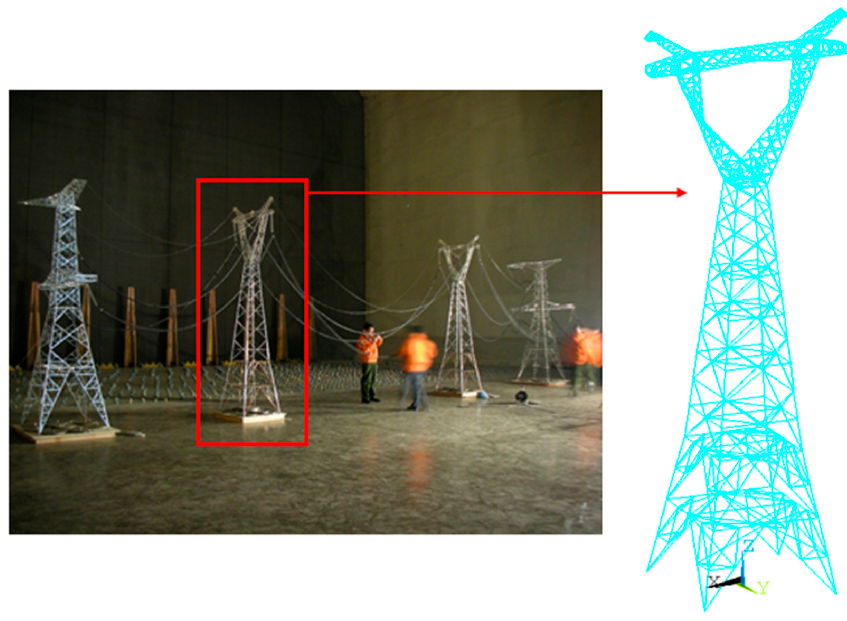
Figure 2. An in-service transmission tower model.